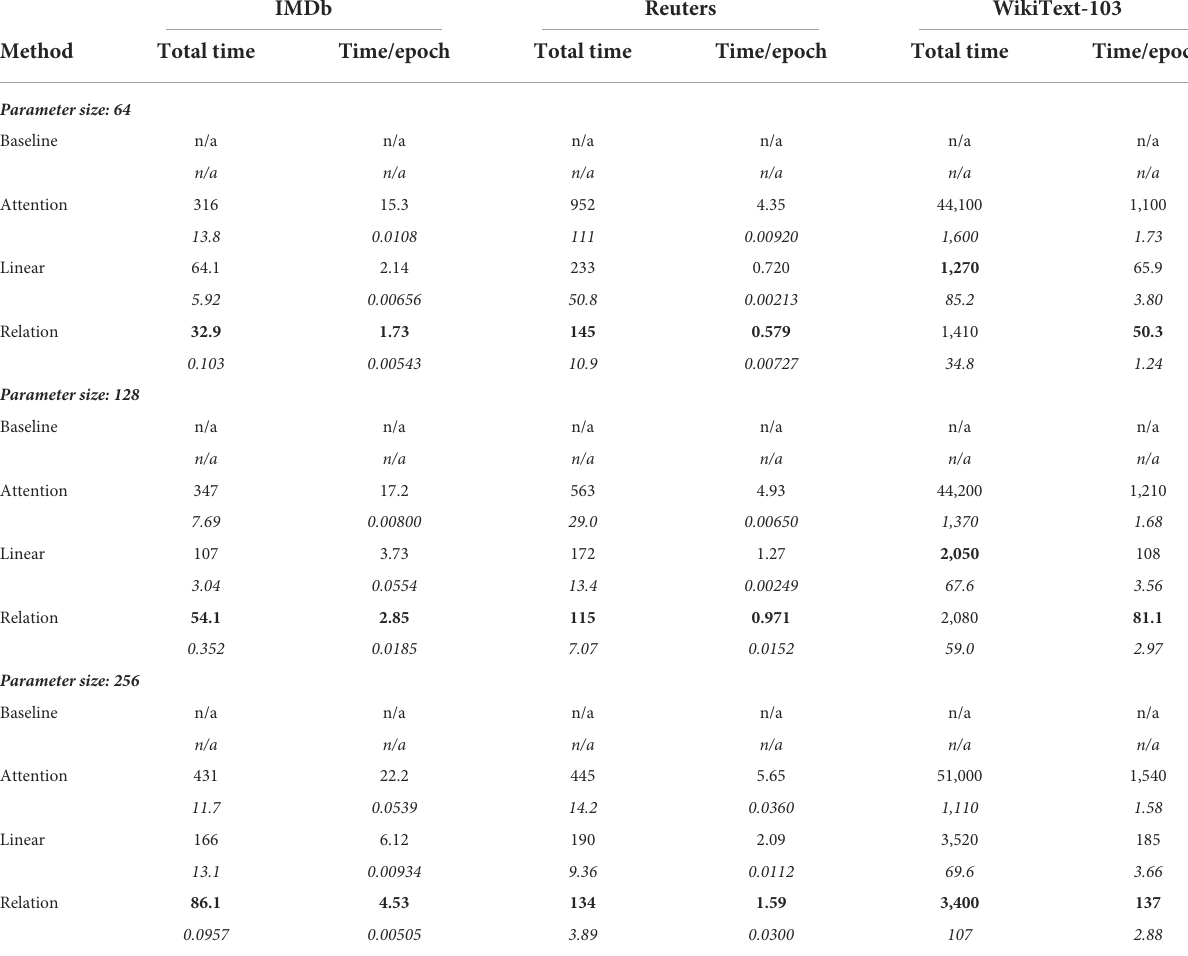
TABLE 2 Computation time (s) of learning phase for IMDb, Reuters, and WikiText-103. IMDb Reuters